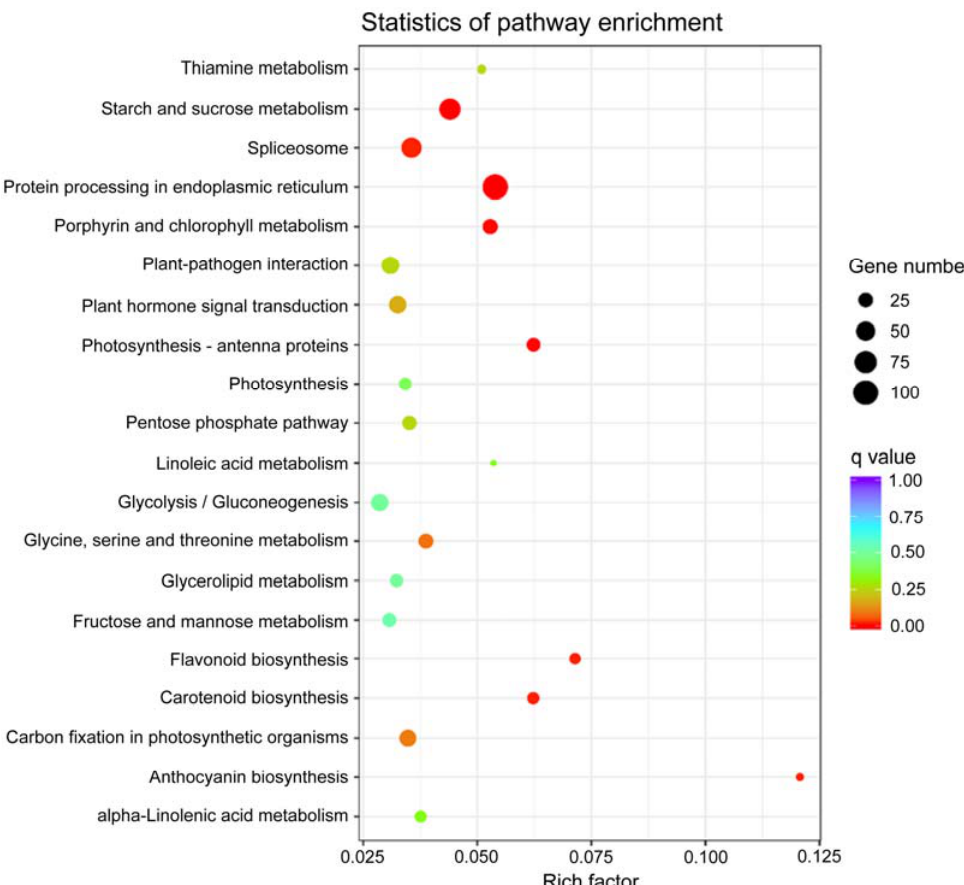
Figure 4. KEGG pathway enrichment analysis of upregulated DEGs in N. tangutorum . The horizontal axis represents the enrichment factor corresponding to each pathway. The vertical axis represents the pathway name. Dot colors denote the magnitude of q-values, and their sizes denote the number of DEGs.